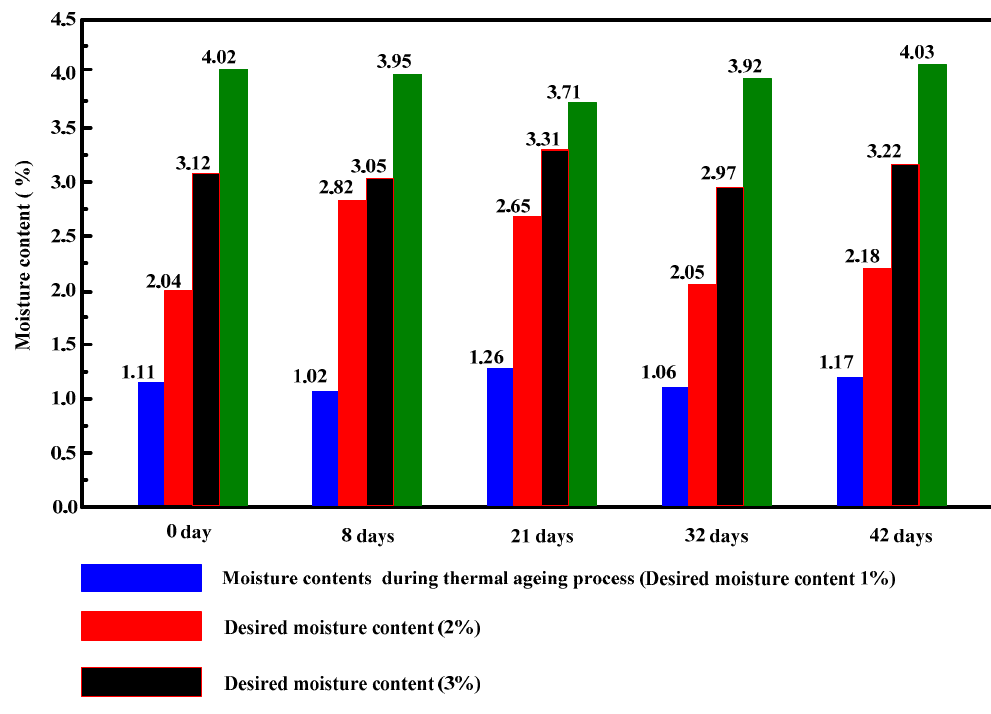
Figure 4. Test results of moisture contents of unaged and aged polymer pressboard specimen.